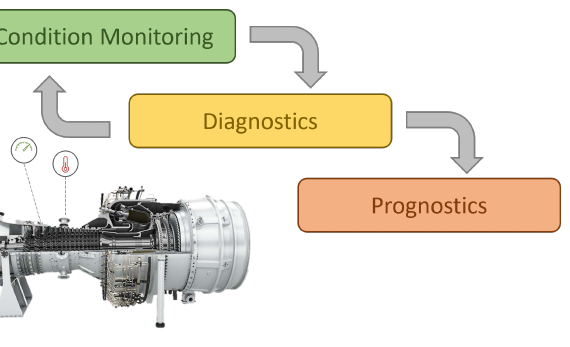
Figure 1. Outline of a gas turbine’s condition monitoring, diagnostics, and